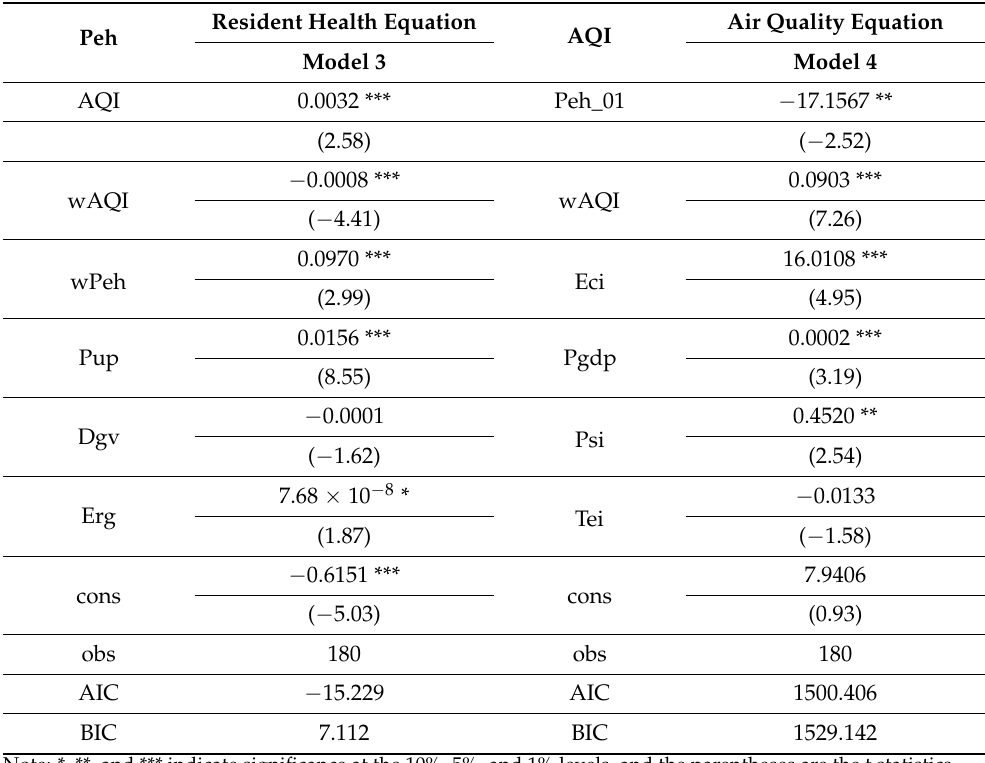
Table 2. Impact of air quality on case fatality